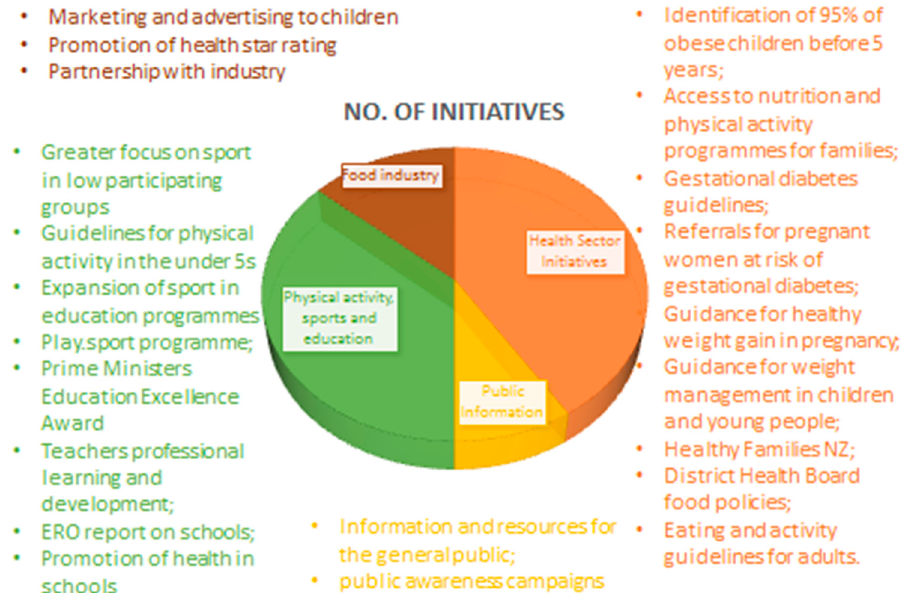
Figure 2. The initiatives outlined in the New Zealand Childhood Obesity Plan. Initiatives can be broadly categorized into government agency led, physical activity focused, health sector focused, or involving the food industry. Adapted from a New Zealand Ministry of Health report [14]. ERO-Education Review Office.